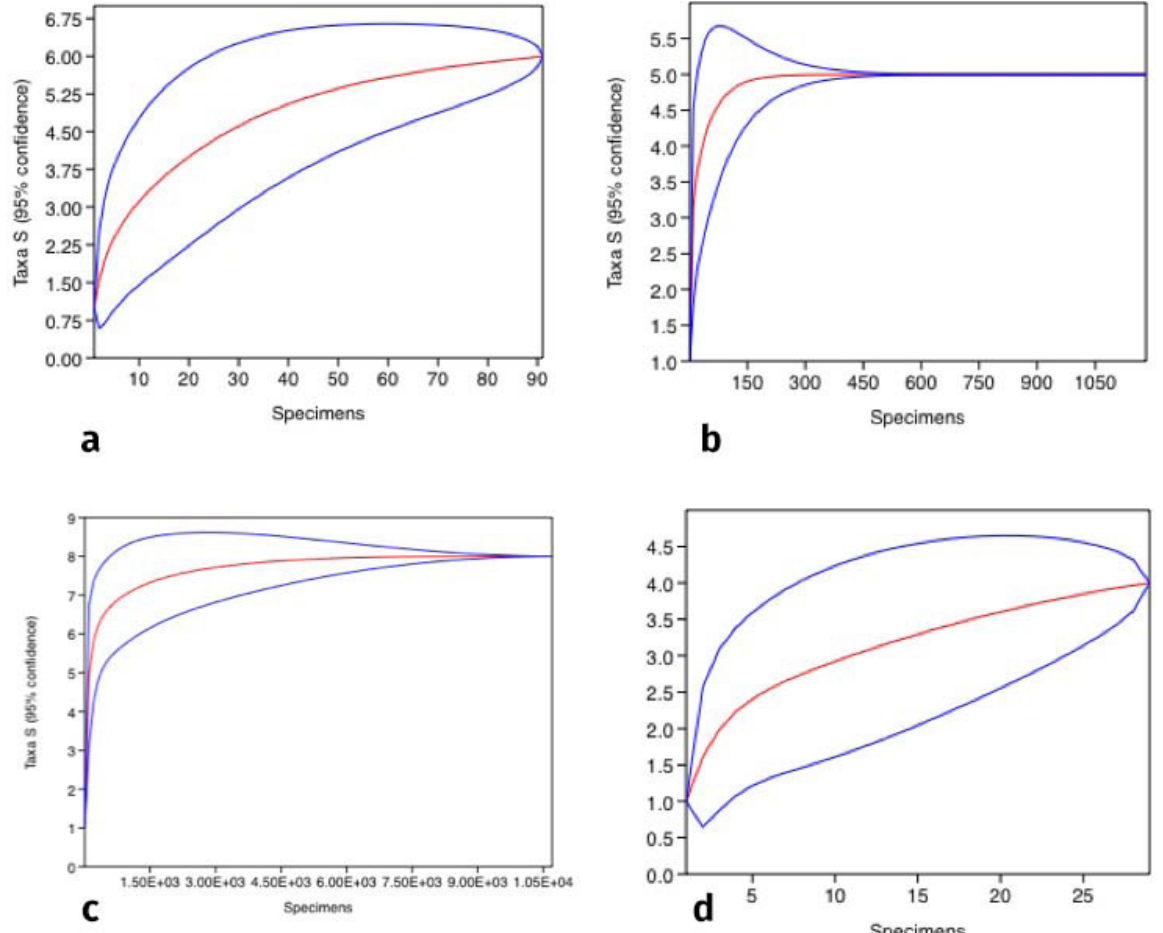
Figure. 2. Rarefaction curves for samples from (a) King George Island (b) Greenwich Island, (c) Antarctic Peninsula 2, (d) Arctowski Peninsula. Due to low numbers of taxa detected, it was not possible to generate rarefaction curves for the remaining samples. Blue lines represent 95% confidence